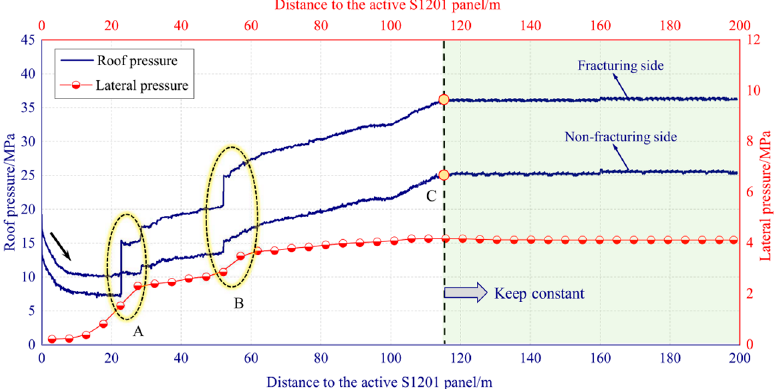
Figure 20. Monitoring results of the roof and lateral pressures in the S1201 headentry. The red line shows the variation in the lateral pressure, and the blue line presents the monitoring results of the roof pressure.